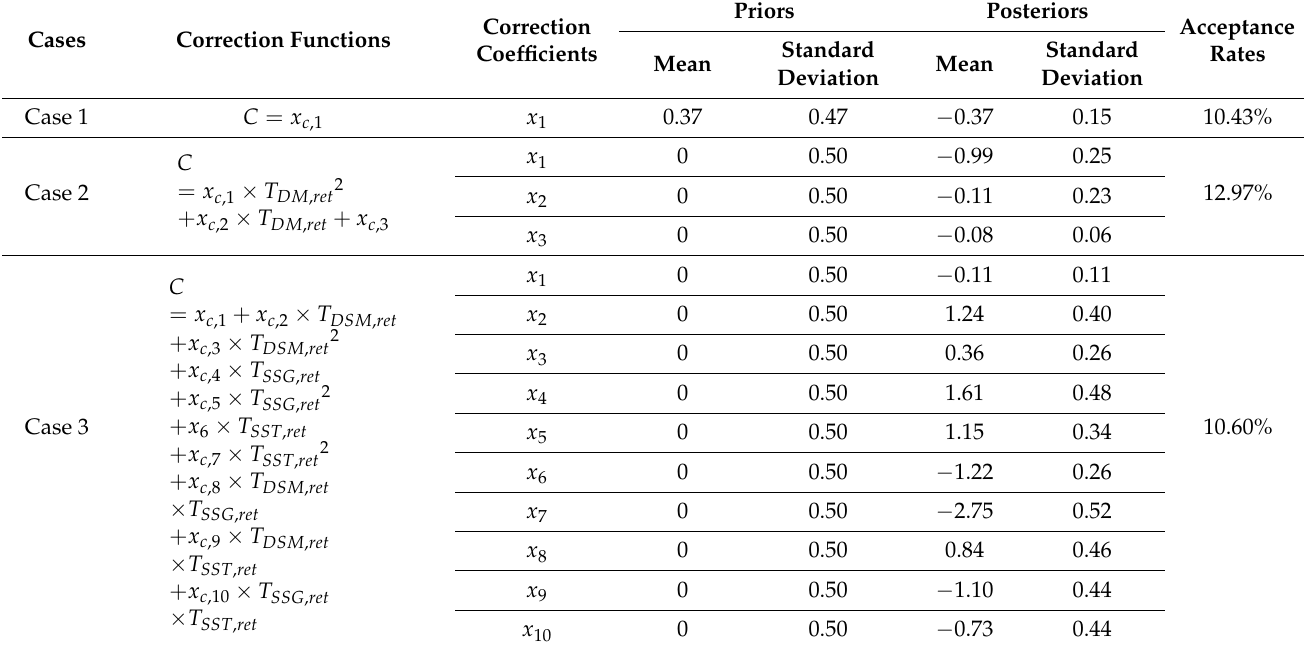
Table 4. Case descriptions regarding correction functions, priors, and posteriors.